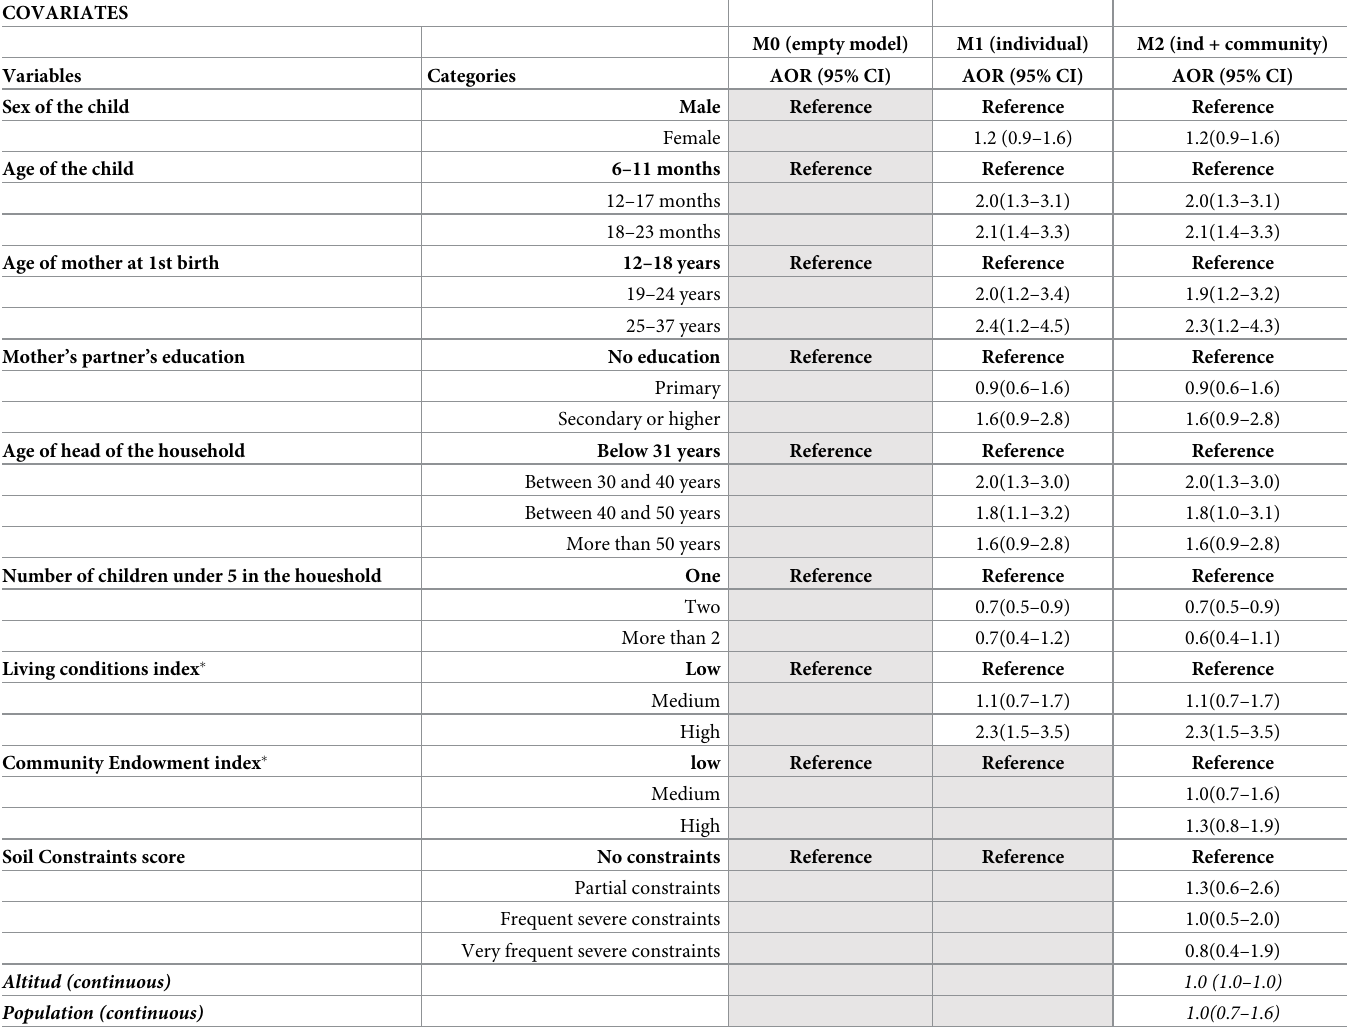
Table 4. Factors associated with MDDw in rural Rwanda DHS2010. Individual and household